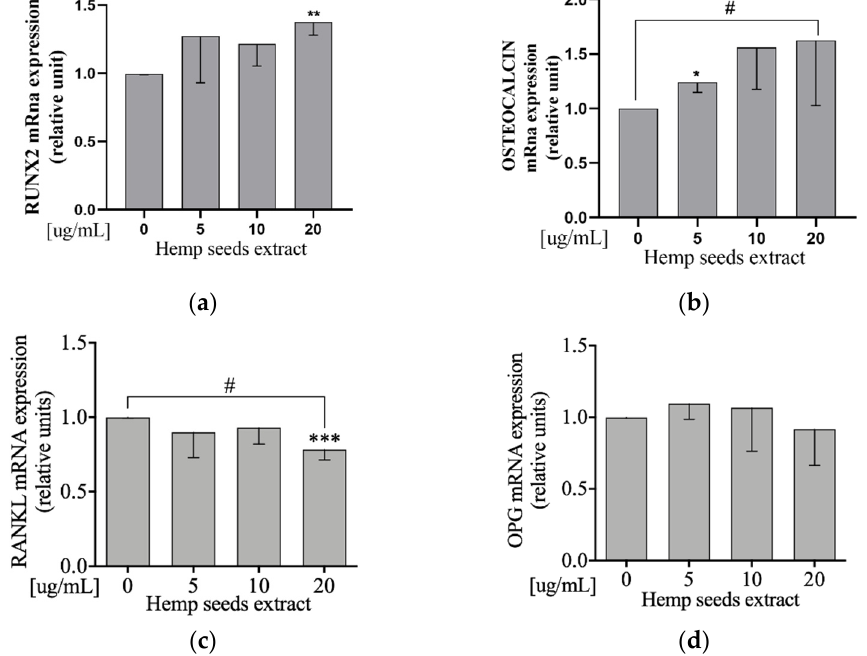
Figure 4. HSE downregulates RANKL and upregulates RUNX2 and Osteocalcin mRna expression levels on Saos-2 cells. Semi-confluent cultures of human osteoblast-like cells (Saos-2) were incubated with HSE 5, 10, or 20 µ g/mL for 24 h. The mRNA expression levels of RANKL ( c ), OPG ( d ), RUNX2 ( a ), and Osteocalcin ( b ) were measured by RT-PCR. Data were analyzed using the 2- ∆∆ Cq method and normalized to β -actin. Data are represented as mean ± SD. Statistical analysis: Student’s t -test vs. 0 * p < 0.05; ** p < 0.01; *** p < 0.001, Linear regression # p <